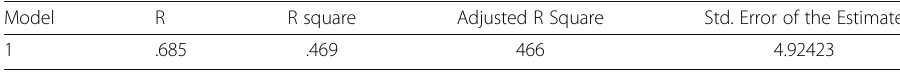
Table 4 Model Summary Model